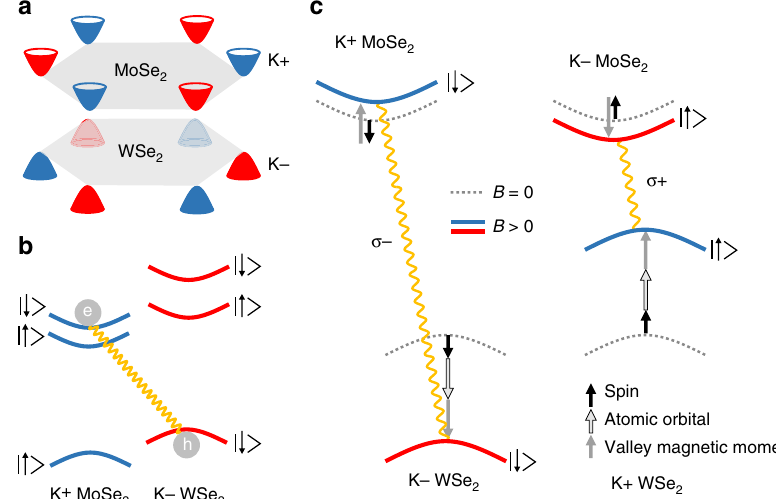
Fig. 3 Giant magnetic valley splitting in an AB-stacking con fi guration. a Momentum space arrangement of the relevant band extrema in an AB-stacked WSe 2 /MoSe 2 heterostructure. Blue (red) depicts electronic bands from the K+ (K − ) valleys. b Type II band alignment of MoSe 2 and WSe 2 for the AB- stacking con fi guration, indicating spin-allowed optically bright interlayer transitions. Arrows indicate spin-up and spin-down states. c Evolution of the transitions such as indicated in b with positive applied magnetic fi eld. Dashed lines indicate the situation for B = 0. The arrows depict the possible contributions to the valley-selective splitting (black for spin, black framed for atomic orbital and gray for valley magnetic